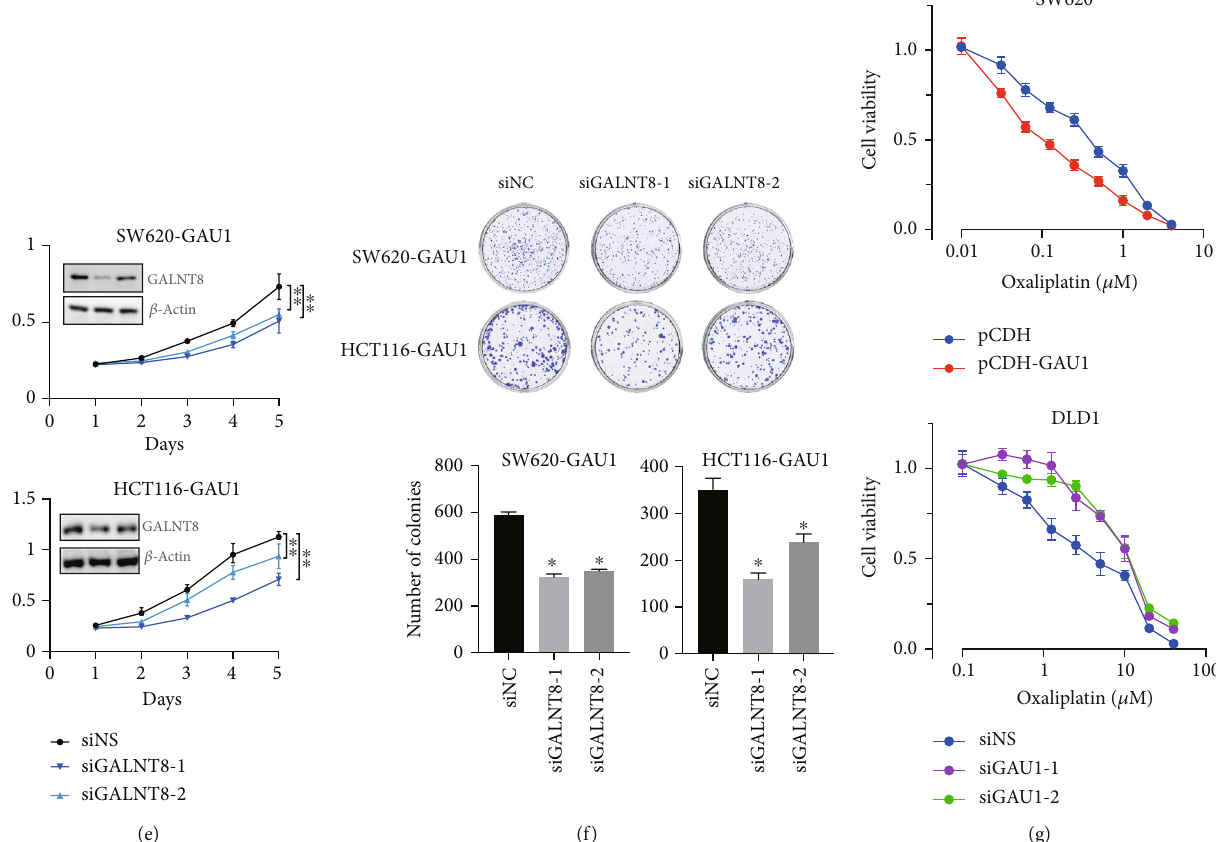
Figure 4: The oncogenic ability of GAU1 is GALNT8 dependent, and overexpression of GAU1/GALNT8 axis sensitizes CRC cell lines to chemotherapy. (a) CCK-8 assay and (b) colony formation assay were used to measure proliferation in SW620 and HCT116 cells transfected with pCDH-GALNT8 or pCDH. ∗ P < 0 : 05 ; ∗∗ P < 0 : 01 . (c) CCK-8 assay and (d) colony formation assay were conducted in control siRNA (siNS) or siRNAs (siGALNT8-1 and siGALNT8-2) against GALNT8-transfected DLD1 and LoVo cells. ∗ P < 0 : 05 ; ∗∗ P < 0 : 01 . (e, f) Proliferation analysis by (e) CCK-8 assay and (f) colony formation assay in GAU1 -overexpressed SW620 and HCT116 cells transfected with control siRNA (siNS) or siRNAs (siGALNT8-1 and siGALNT8-2) against GALNT8. ∗ P < 0 : 05 ; ∗∗ P < 0 : 01 . (g) Viability of pCDH-GAU1- or pCDH-transfected SW620 and siGAU1-1/2- or siNS-transfected DLD1 cells incubated with multiple concentrations of oxaliplatin (0.01-40 μ M) was monitored through CCK-8